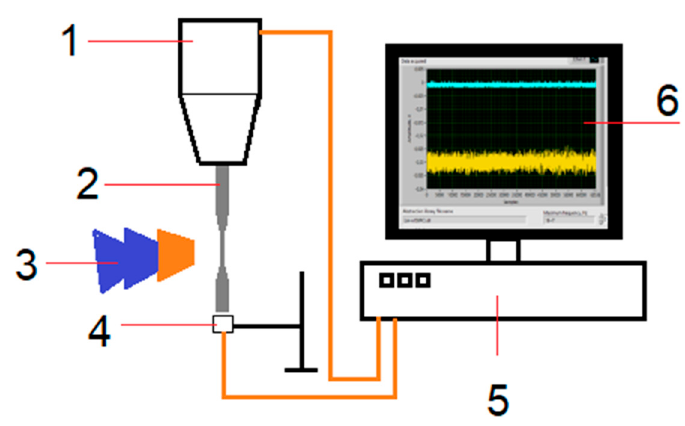
Figure 4. The experimental setup: 1—horn, 2—specimen, 3—cooling system, 4—displacement sensor, 5—controlling and analog-digital converter system, 6—analyzing software.